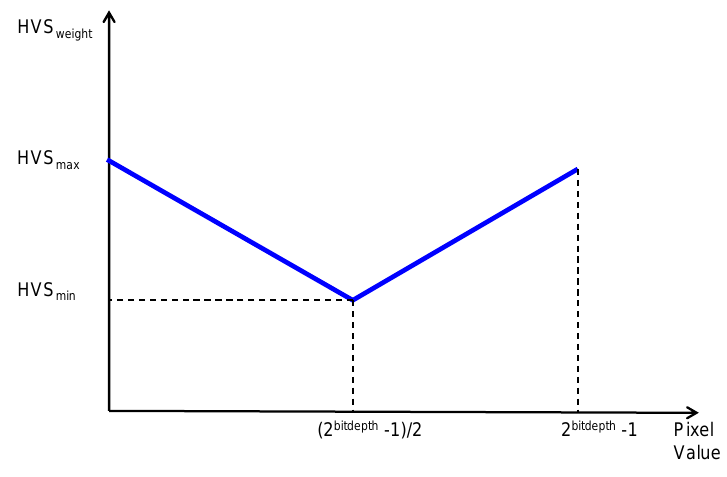
Figure 3. HVS curve used in the proposed